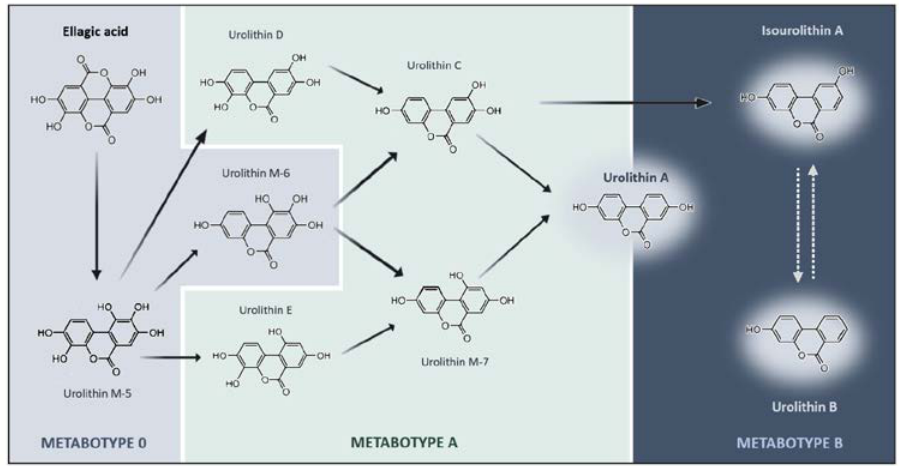
Figure 1. Schematic representation of ellagic acid catabolic pathway by colonic microbiota and the respective urolithin metabotypes . Ellagic Acid (EA) is metabolized into bioactive metabolites through lactone-ring cleavage, decarboxylation, and dihydroxylation reactions. Depending on the individual’s microbiota composition, EA can be metabolized into dis- tinct types of urolithins. Such differences can be stratified into three metabotypes (A, B, and 0), depicted by specific color codes. Metabotype 0 (gray) does not produce the final urolithins at least in detectable concentrations. Metabotype A (yel- low) is characterized by the production of urolithin A and its conjugates. Metabotype B (green) is characterized by the production of urolithin B, urolithin A, and isourolithin A. The chemical structures represented indicate the intermediates and final metabolites that are produced along the different pathways of ellagic acid metabolism.